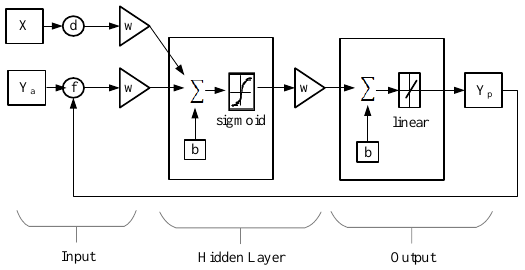
Figure 2. Structure of the parallel NARX network “closed-loop”. The network has a feedback link from the output layer, where the predicted output Y p is looped back to the input layer in order to perform multi-step-ahead forecasting.